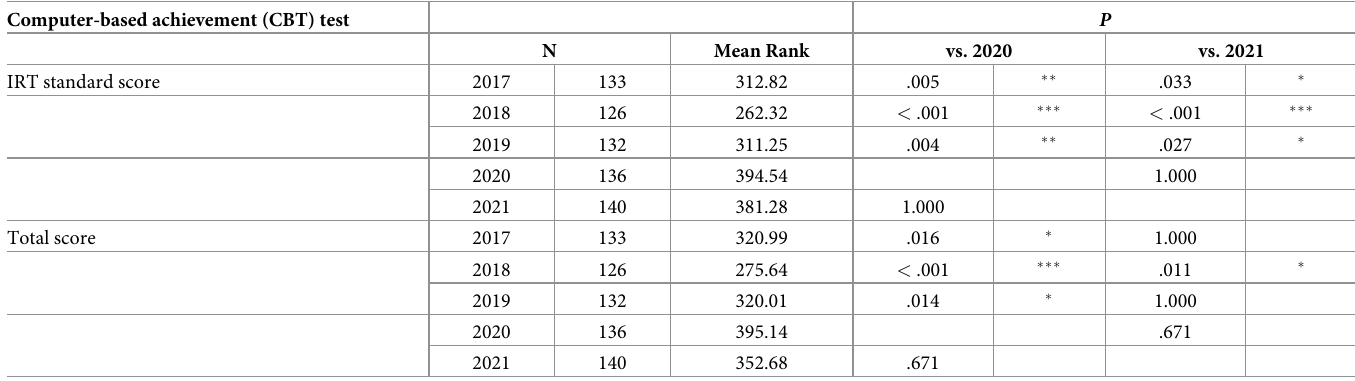
Table 5. Dunn–Bonferroni test comparison of CBT sections between 2020 and 2021. Computer-based achievement (CBT)